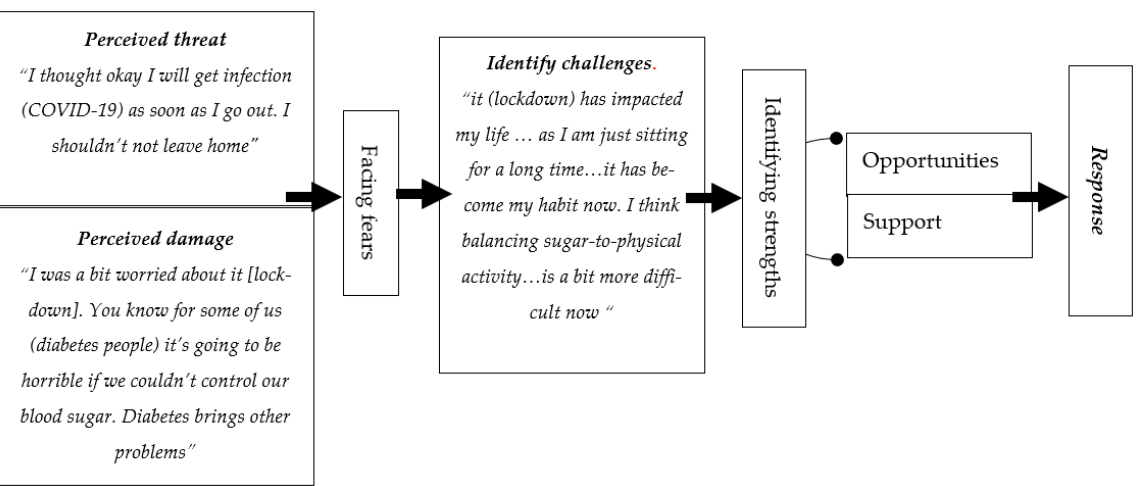
Figure 1. Summary of the study findings in relation to the theoretical assumption .